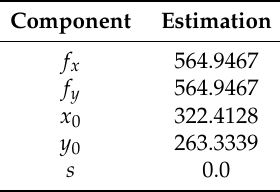
Table 2. Calibrated intrinsic parameters of the endoscopic